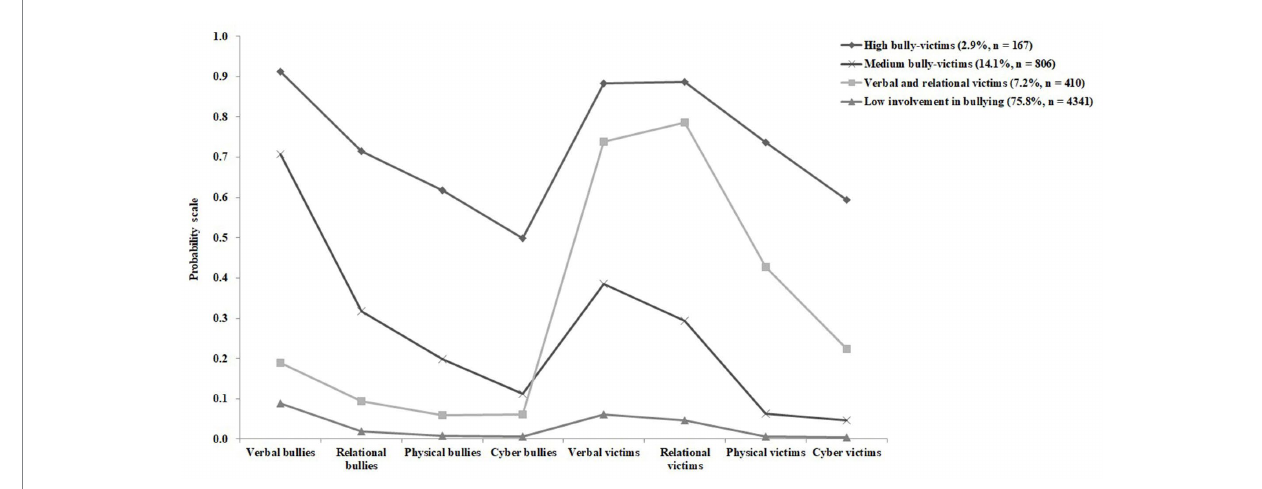
FIGURE 1 Probability of involvement in school bullying for a four-classes